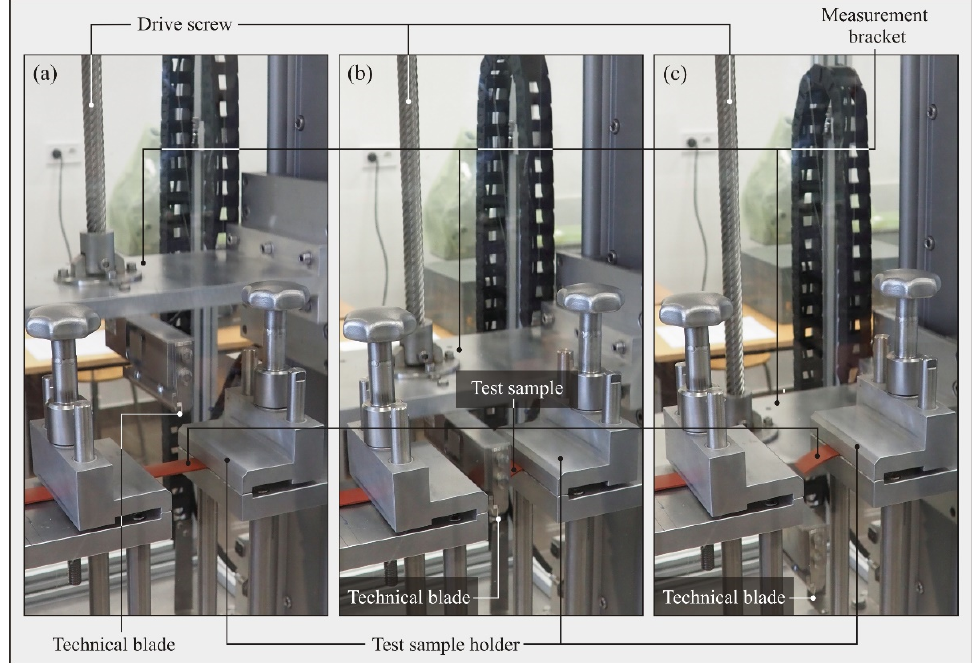
Figure 5. Visualization of the process of cutting through the test sample made of polyurethane: ( a ) initial stage—the blade approaches the test sample with a uniform motion at a remote speed; ( b ) second stage—cutting through the test sample; ( c ) third stage—completion of the test after moving the knife below the cutting zone.